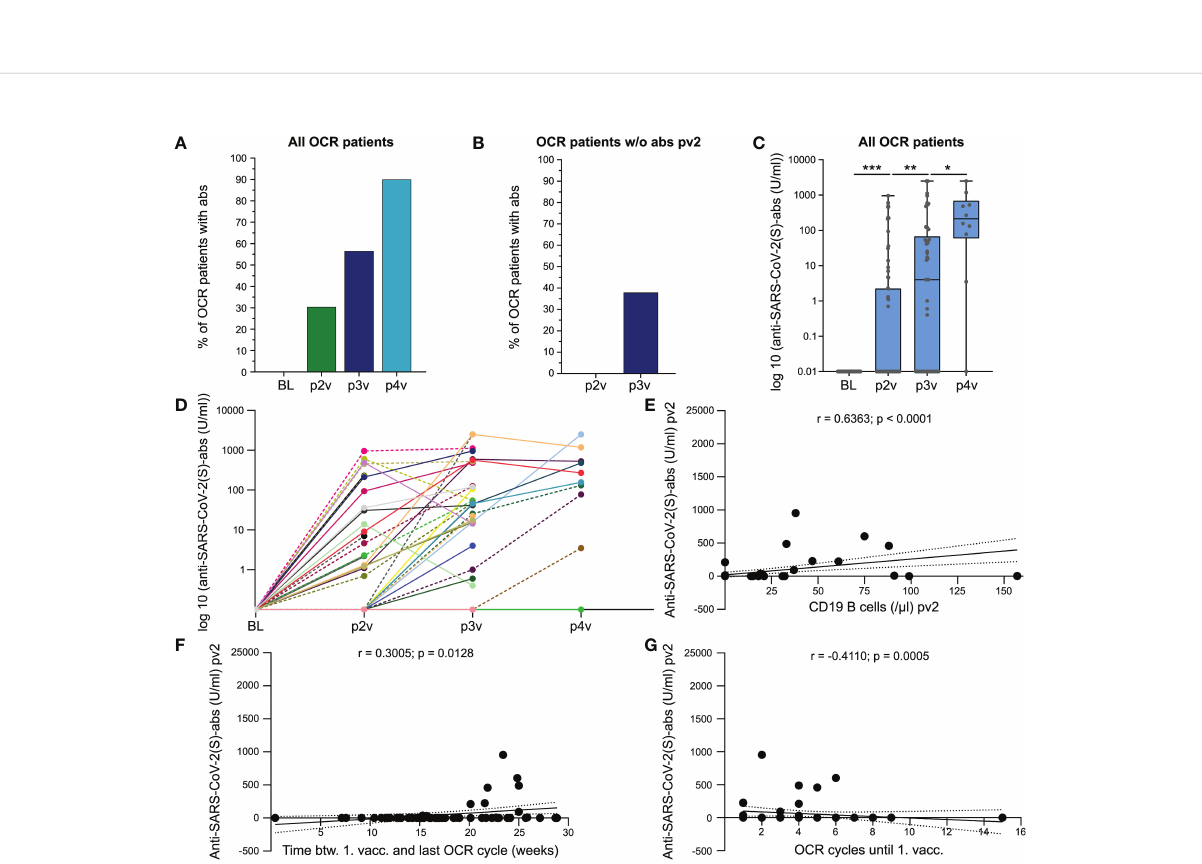
FIGURE 2 COVID-19 booster vaccinations can increase humoral immune response in MS patients treated with ocrelizumab. (A) Percentage of OCR-pwMS with positive anti-SARS-CoV-2(S)-antibodies post second, third, and fourth vaccination; (B) Seroconversion after the third vaccine shot in previously antibody negative OCR-pwMS; (C) Anti-SARS-CoV-2(S)-antibody titers post second, third, and fourth vaccination. Values < 0.4 U/ml are depicted on the x-axis; (D) Individual anti-SARS-CoV-2(S)-antibody titers at BL, pv2, pv3 and pv4. Connection lines between the time points serve as orientation and do not re fl ect the anti-SARS-CoV-2(S)-antibody level between two time points; Correlation of anti-SARS-CoV-2(S)-antibodies with CD19 B cell count pv2 (E) , time between fi rst vaccination and last OCR cycle (F) , and number of previous OCR cycles (G) . Correlation analyses were performed with the Spearman correlation coef fi cient. The area in-between the dotted lines shows the 95% con fi dence interval. Abs, antibodies; BL, baseline; btw, between; COVID-19, coronavirus disease 2019 ; OCR, ocrelizumab; pv2/3/4, post second/third/fourth vaccination; S, spike; SARS-CoV-2, severe acute respiratory syndrome; w/o, without; vacc., vaccination. *p ≤ 0.05, **p ≤ 0.01, ***p ≤